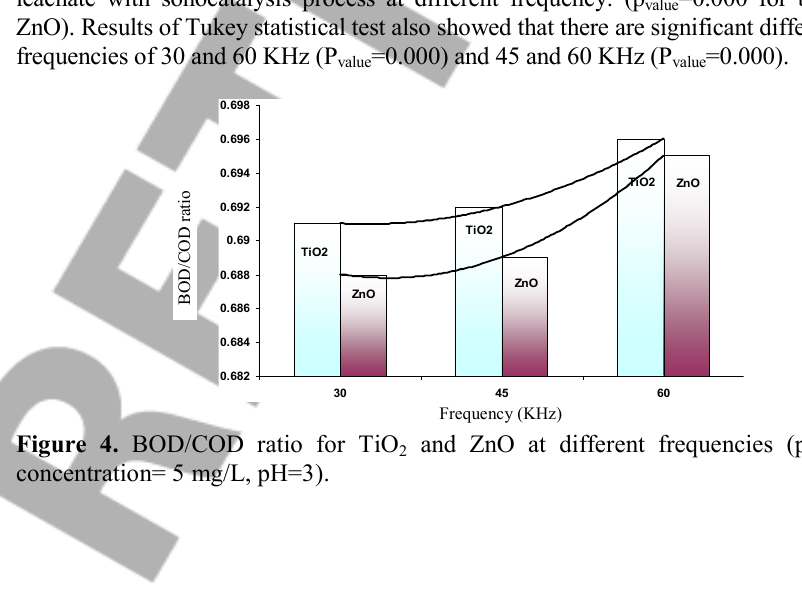
and ZnO at different frequencies (power=70watt, 2